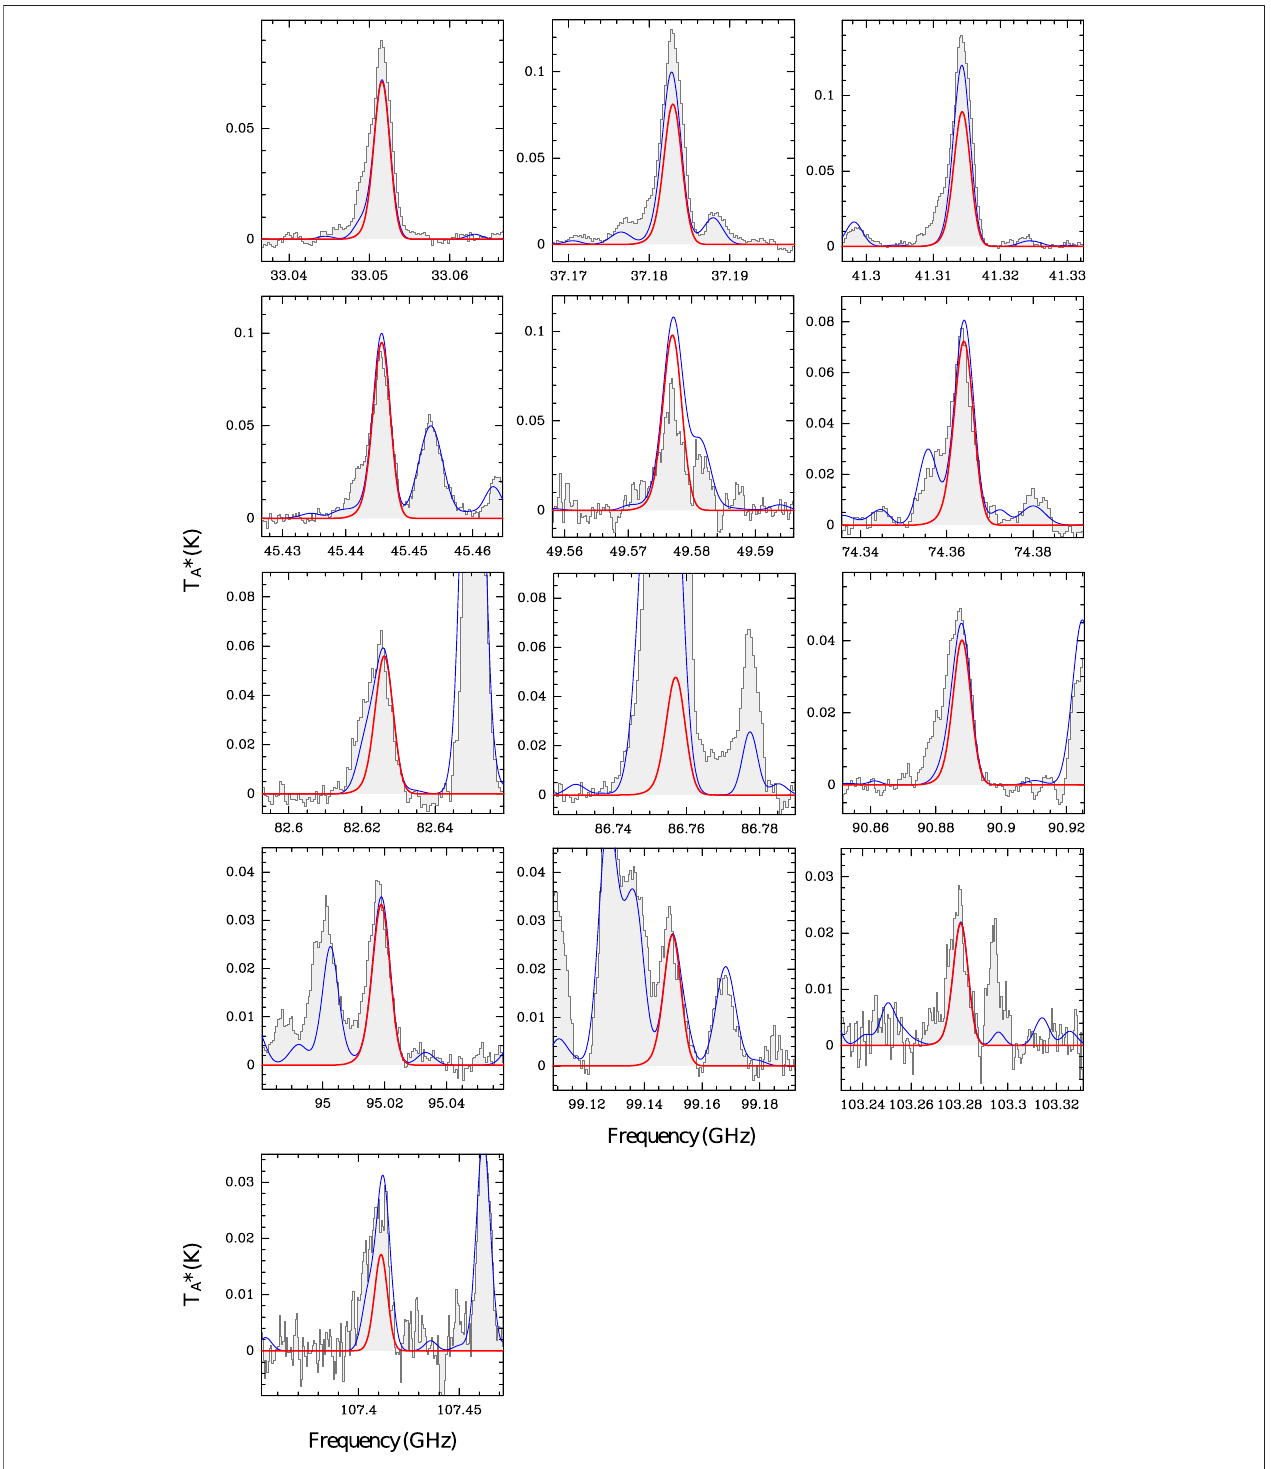
FIGURE 7 | Selected transitions of cyanopropyne (CH 3 CCCN; see Table 3 ) detected towards the G+0.693 molecular cloud. The best LTE fi t derived with MADCUBA for the CH 3 CCCN emission is shown with a red curve, while the blue curve shows the total emission considering all the species identi fi ed towards this molecular cloud. The y-axis shows the line intensity in antenna temperature scale ( T A * ) in Kelvin, and the x-axis shows the frequency in GHz.